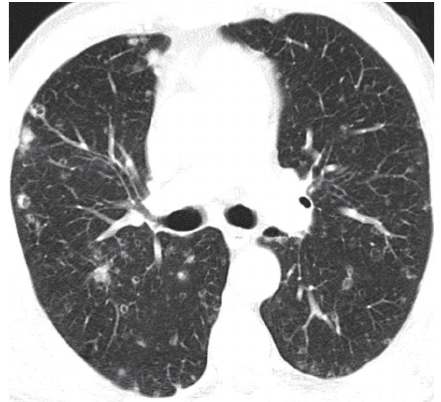
Figure 5: Magnification of axial contrast-enhanced abdominal CT: liver nodules can be best appreciated, some confluent. Note the hypodense area (fat attenuation values) of one of the nodules, indicating xanthomatous type